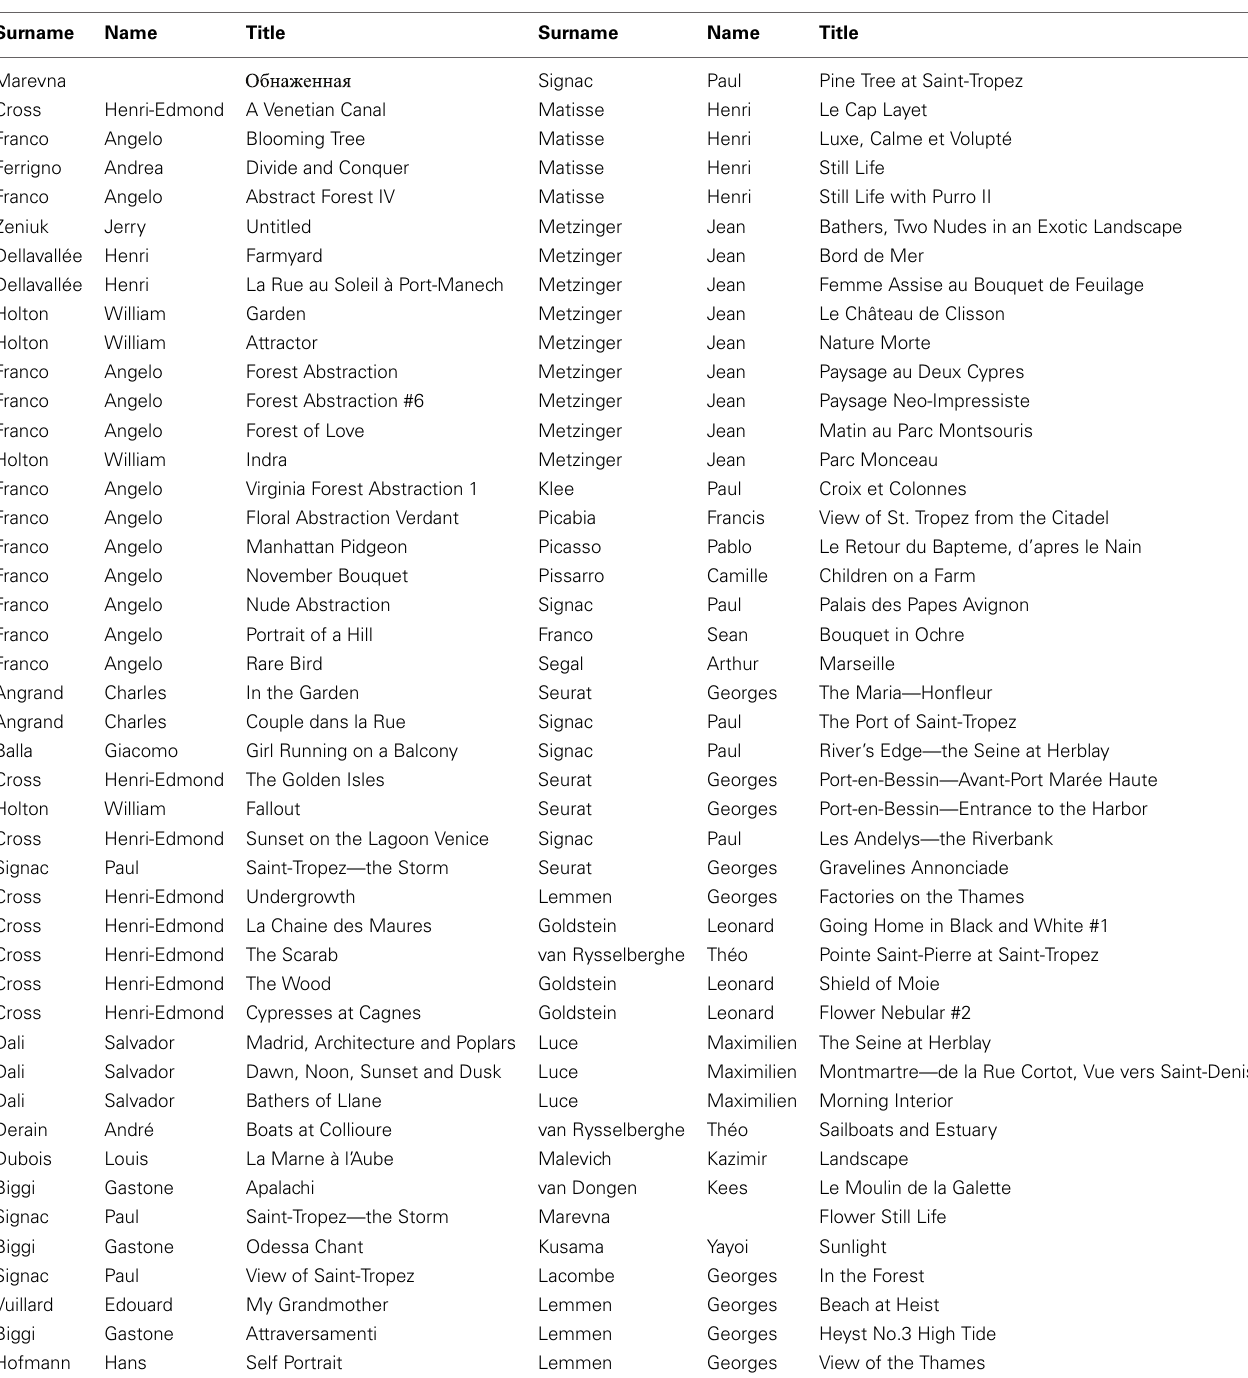
Table 1 | List of the pointillist-style paintings used in the